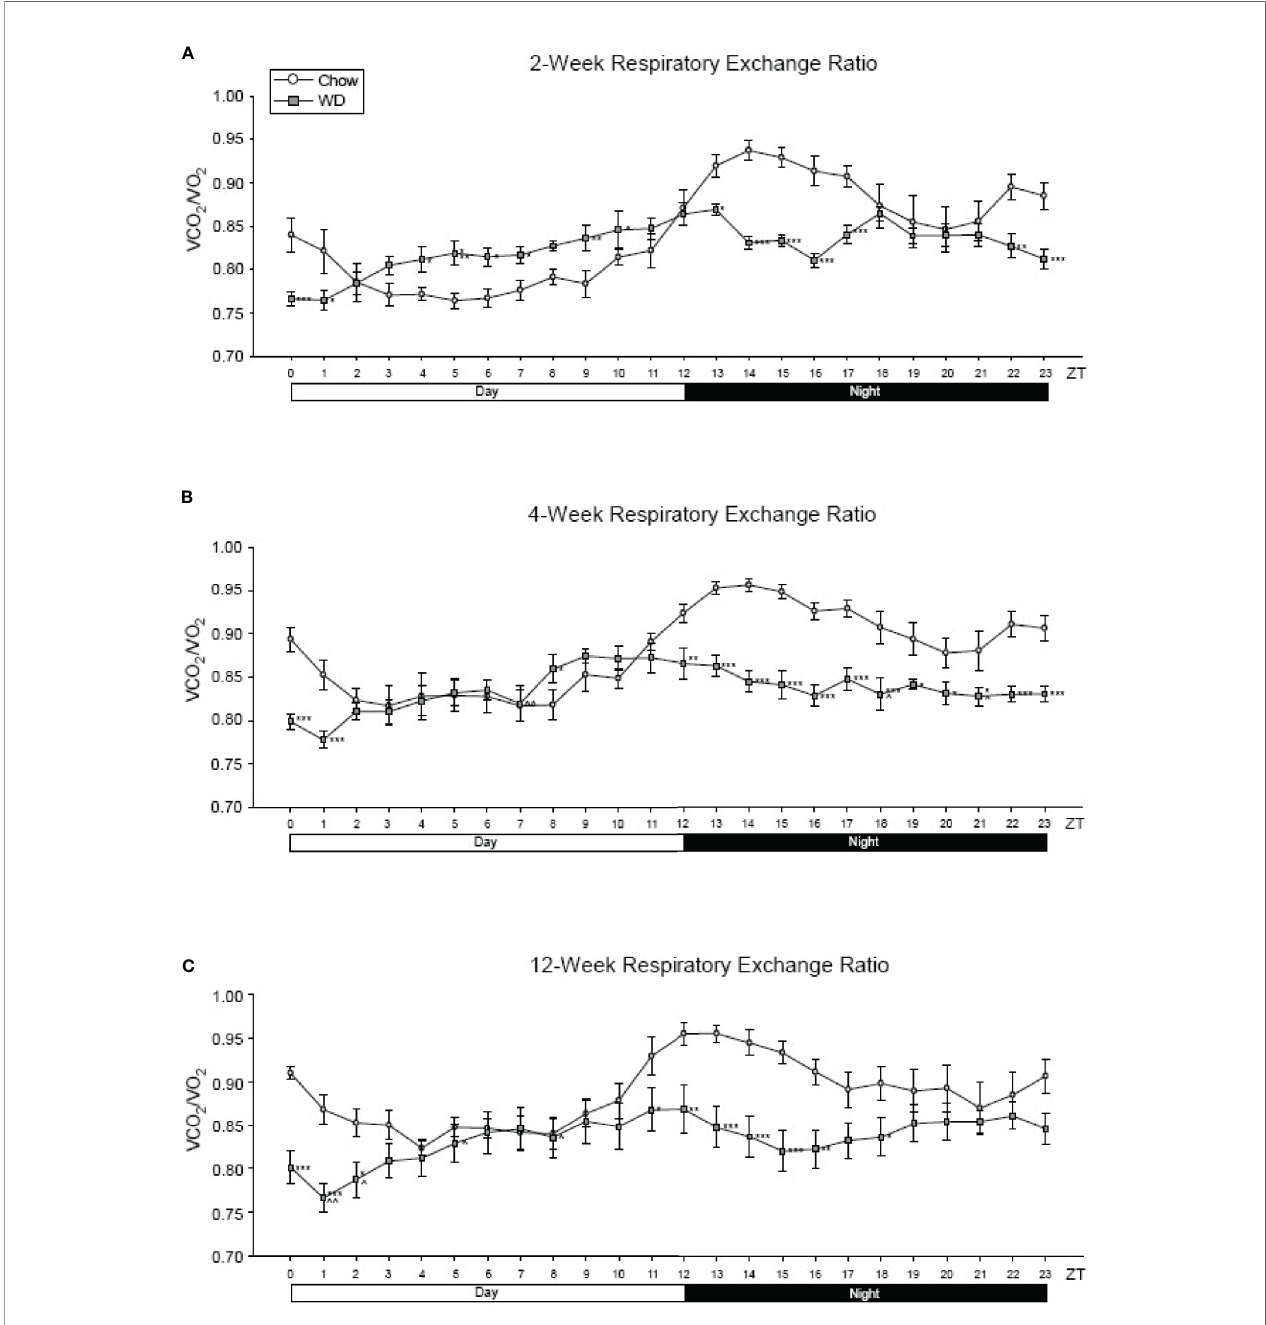
FIGURE 3 | Respiratory exchange ratio at 2-, 4- and 12-weeks. (A) Mean circadian analysis of respiratory equivalent ratio at each hour in the 24-hour cycle in the Chow and WD groups after 2-weeks of dietary exposure. (B) Mean circadian analysis of respiratory equivalent ratio at each hour in the 24-hour cycle in the Chow and WD groups after 4-weeks of dietary exposure. (C) Mean circadian analysis of respiratory equivalent ratio at each hour in the 24-hour cycle in the Chow and WD groups after 12-weeks of dietary exposure. All data points are shown as group mean ± SE. (*p < 0.05, **p < 0.01, ***p < 0.001 compared to